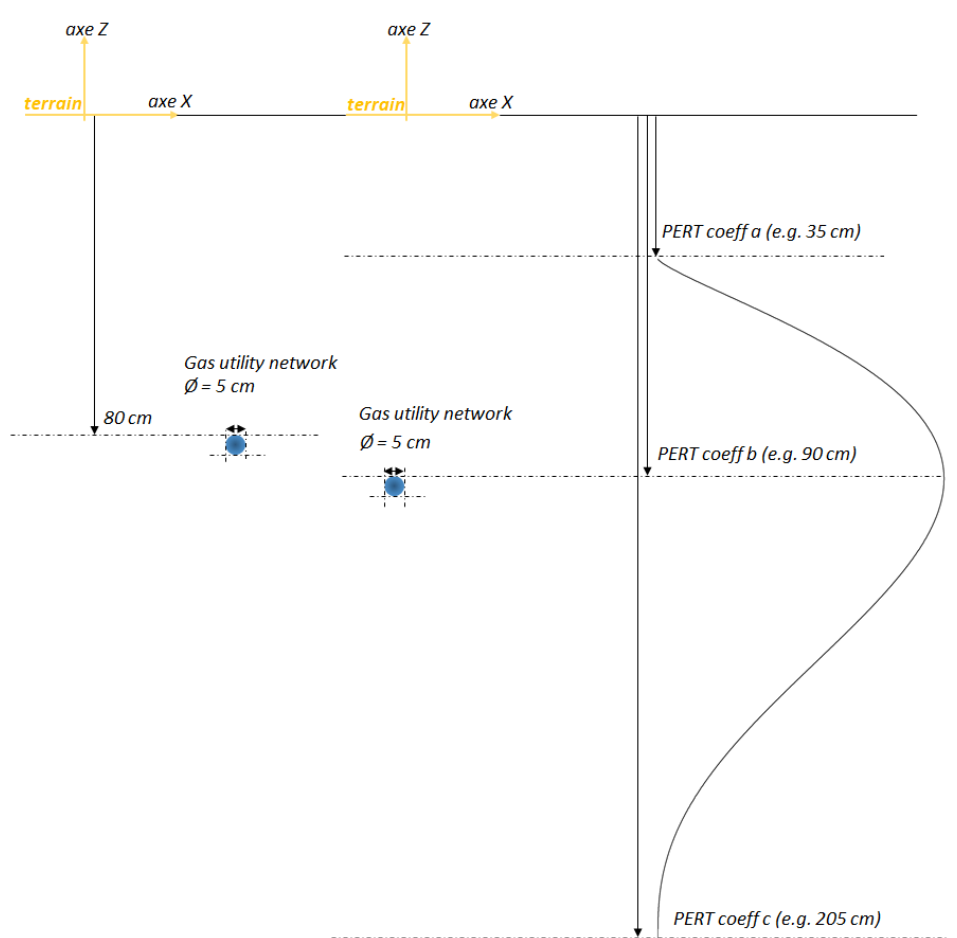
Figure 9. Calibration of a minimum ground cover when no data is available ( left side) or when local is available ( right side).